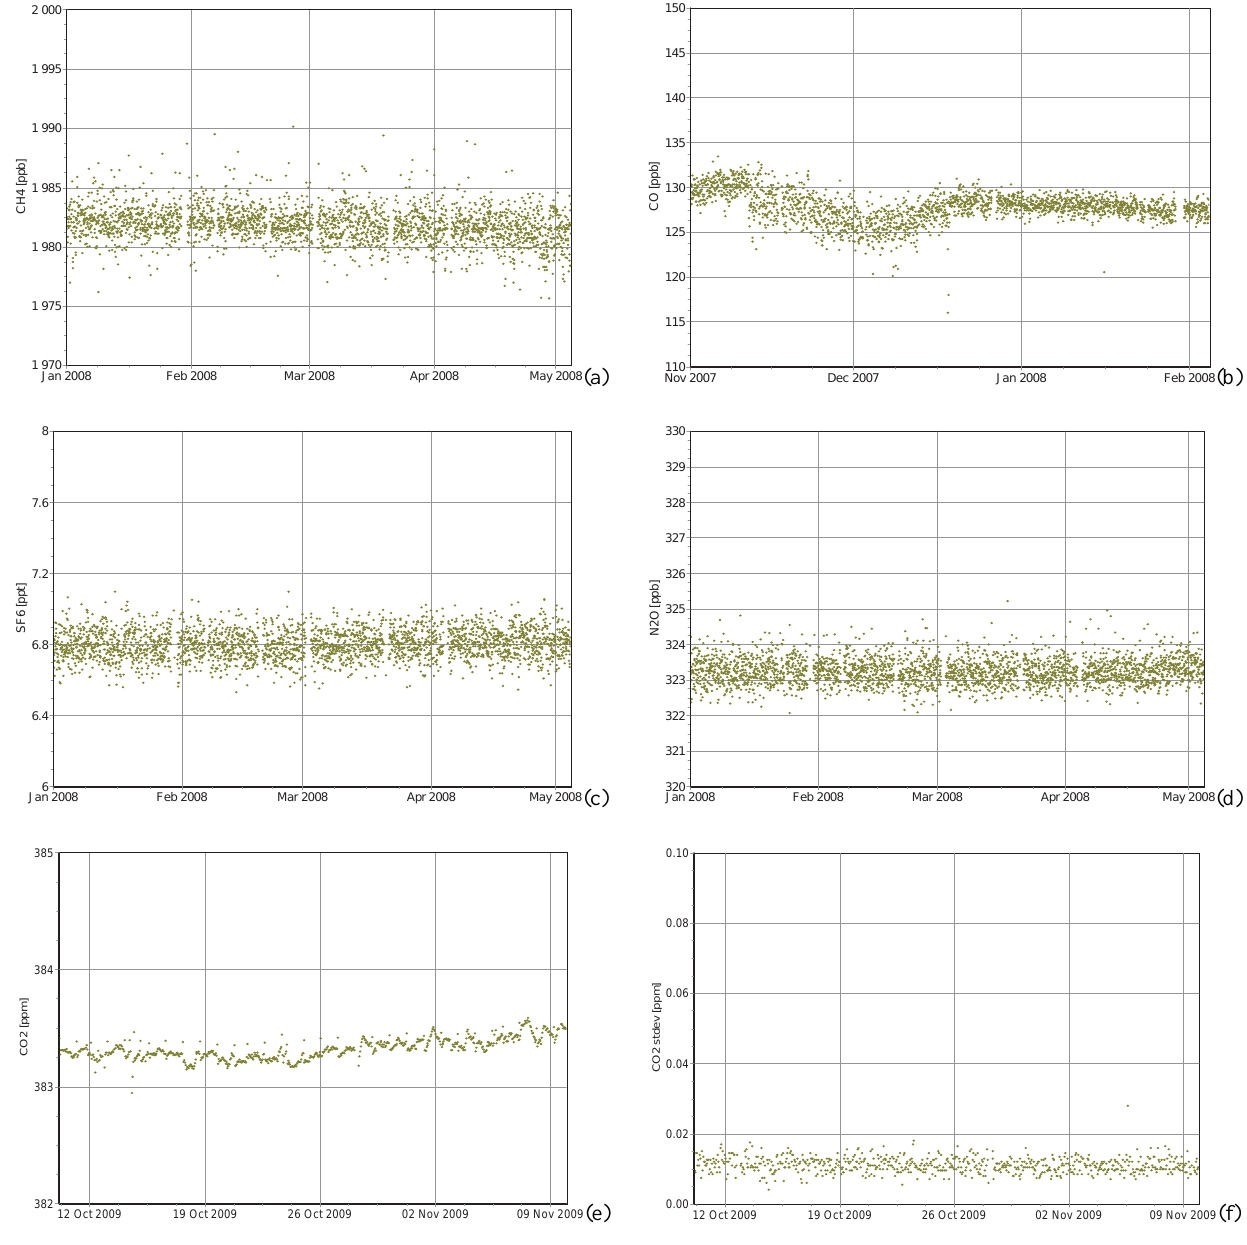
Fig. 8. Concentration of Target gas 3 for CH 4 (a) , CO (b) , SF 6 (c) and N 2 O (d) after correction of the GC response to Target gas 4 for a 6month period. Similarly (e) is the typical NDIR measured CO 2 concentration for Target gas 2 (without correction for Target gas 1), (f) shows the standard deviation of the half-hourly measurements of the CO 2 concentrations in Target gas 2 over a 4month period.